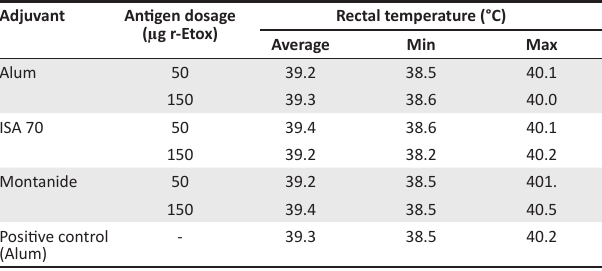
TABLE 3: Safety of enterotoxaemia candidate vaccines in sheep. Adjuvant